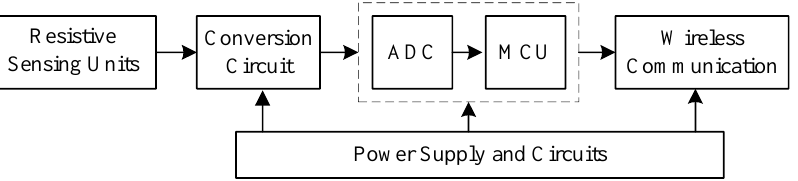
Figure 1. The composition of a typical smart sensor.